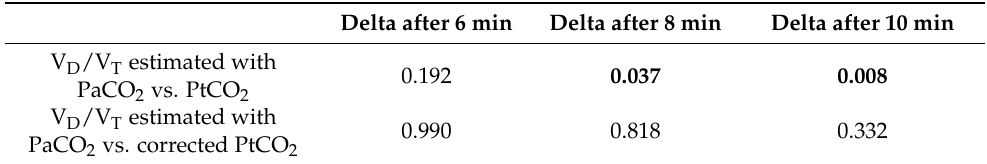
Figure 7. Boxplots of the deltas of V D /V T estimated with PaCO 2 , PtCO 2 and corrected PtCO 2 . The deltas are evaluated at 6, 8 and 10 min with respect to the values measured after 2 min. Table 4. p -values after the pairwise comparisons of deltas obtained with V D /V T estimated with PtCO 2 and corrected PtCO 2 with respect to deltas of V D /V T estimated with PaCO 2